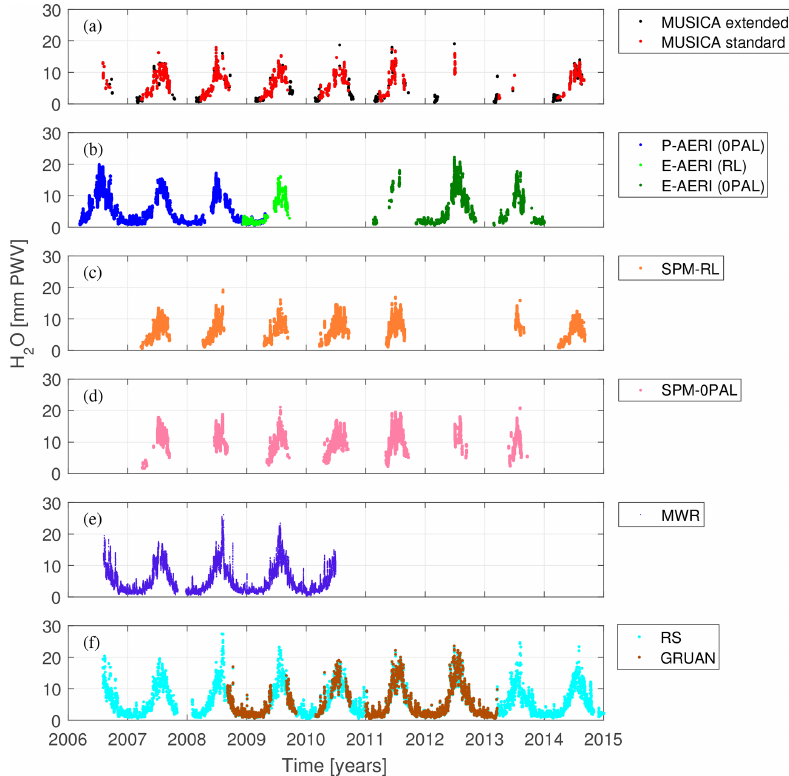
Figure 3. Total column precipitable water vapour (PWV) at Eureka. (a) 125HR water vapour. The extended time series has relaxed the MUSICA SZA quality control criterion of the standard MUSICA time series. (b) P-AERI and E-AERI datasets, with location of the E-AERI noted. (c) the Ridge Lab’s SPM dataset. (d) 0PAL’s SPM dataset. (e) MWR dataset. (f) Eureka Weather Station radiosonde dataset, showing the standard data product as well as the GRUAN